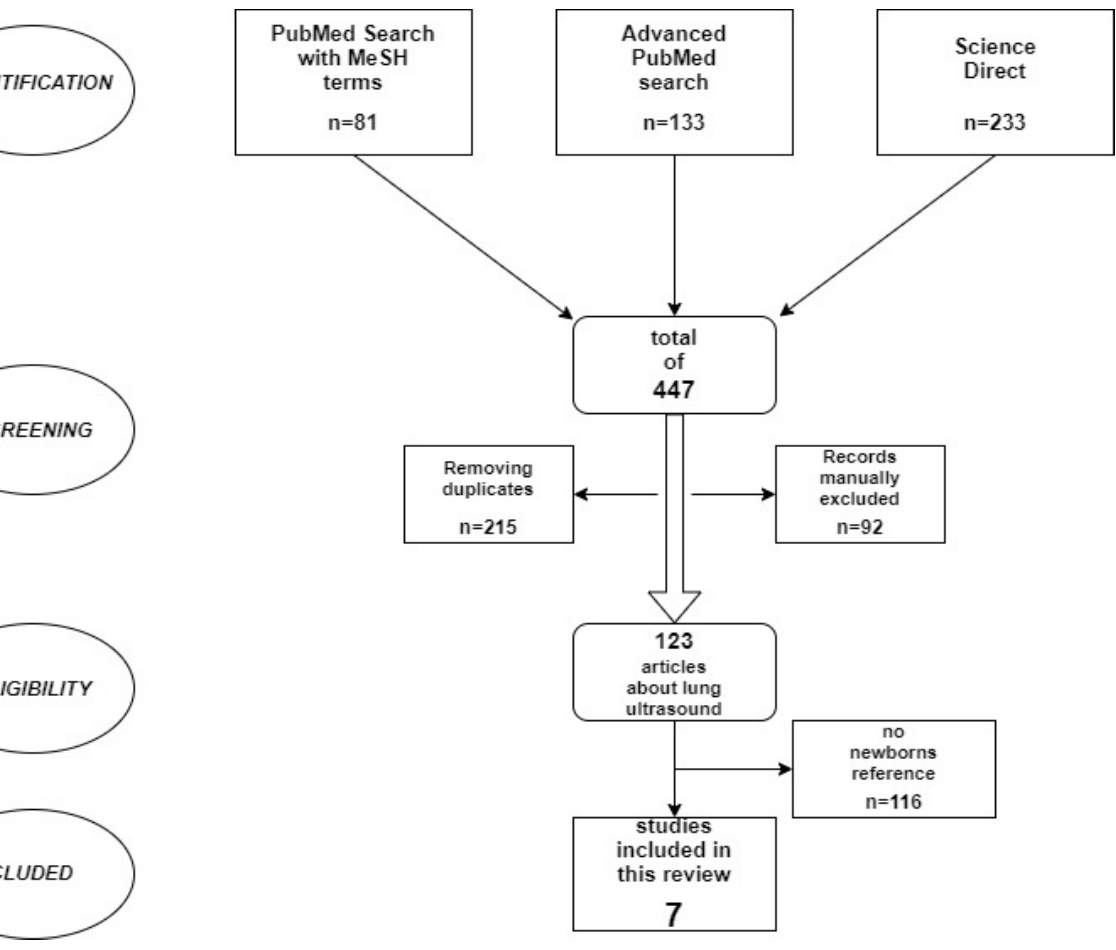
Figure 1. PRISMA flowchart. Literature review.